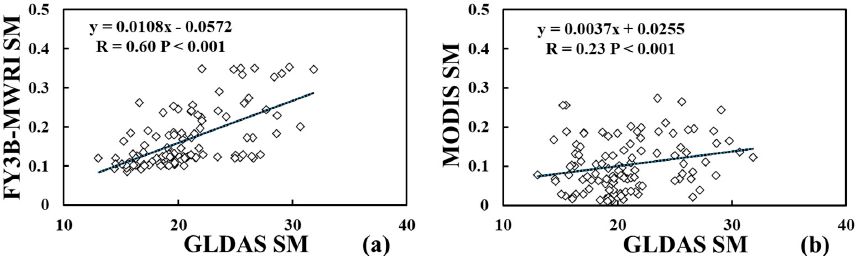
Figure 9. Scatterplot of GLDAS SM and two kinds of satellite SM products, ( a ) FengYun (FY) 3B-Microwave Radiation Imager (MWRI) SM and ( b ) Moderate Resolution Imaging Spectroradiometer (MODIS) SM.